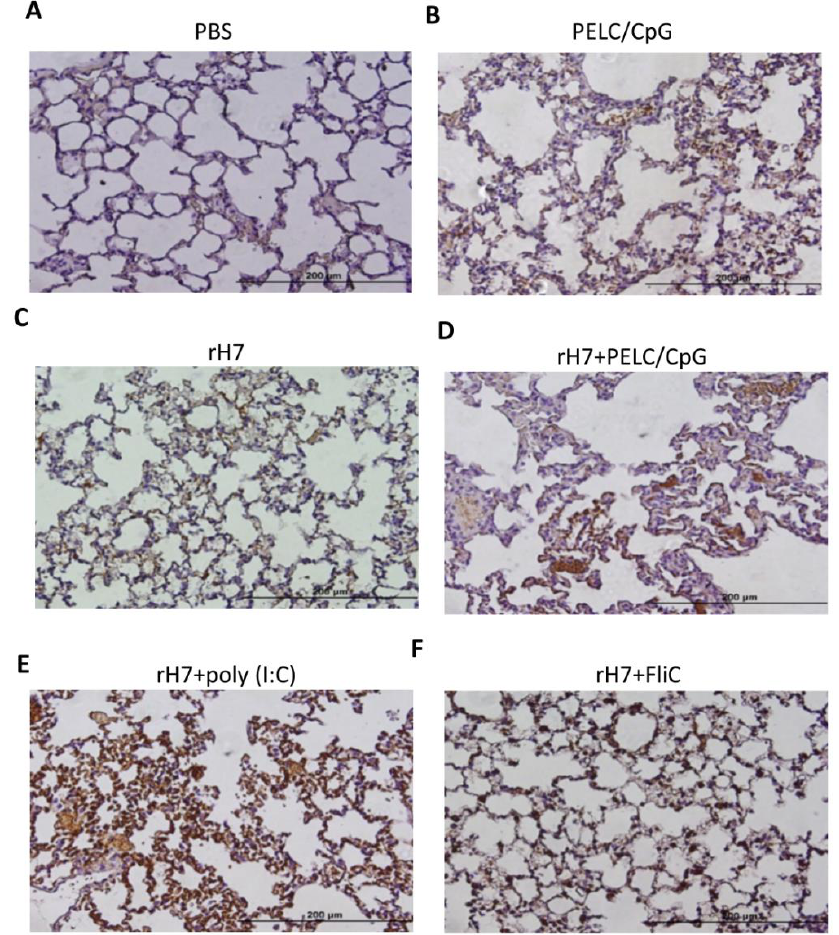
Figure 4. IL-17 expression in lung tissues. One week after the final immunization, lung sections from mice (N = 3 per group) intranasally immunized with ( A ) PBS alone, ( B ) PELC / CpG alone, ( C ) rH7 alone, ( D ) rH7 + PELC / CpG, ( E ) rH7 + poly (I:C), or ( F ) rH7 + FliC were collected and stained with anti-IL-17A antibodies for the observation of IL-17 secretion under an Olympus DP70 microscope ( × 400 magnification).